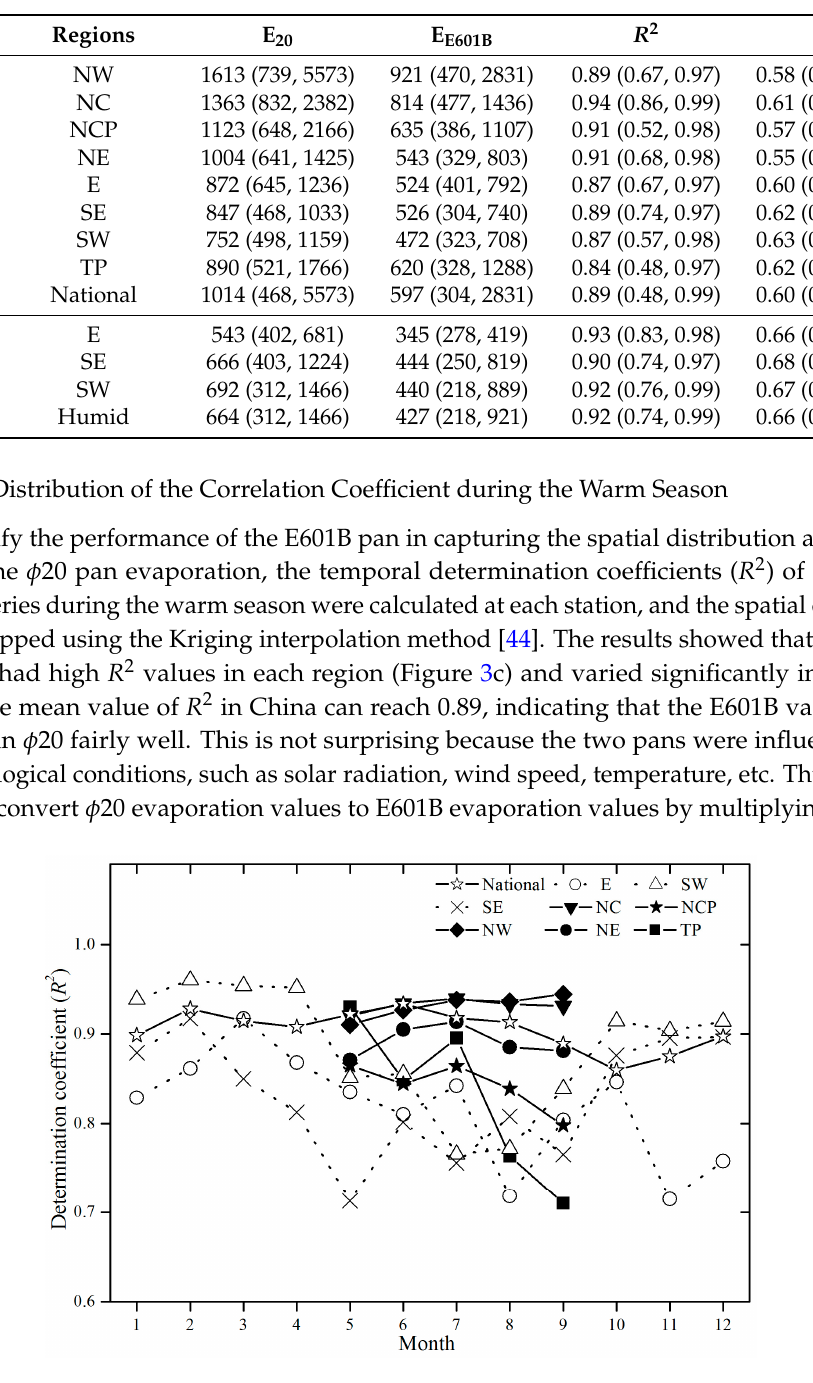
Figure 4. Monthly variation in the coefficient of determination ( R 2 ) values of E601B and φ 20 pan evaporation in the eight climate regions. The R 2 values in the three humid regions (E, SE, and SW) are illustrated by dotted lines, and the R 2 values in the four non ‐ humid regions and TP region are illustrated by solid lines during the warm season (May–September). The national R 2 is illustrated by the solid black line with open star symbols.